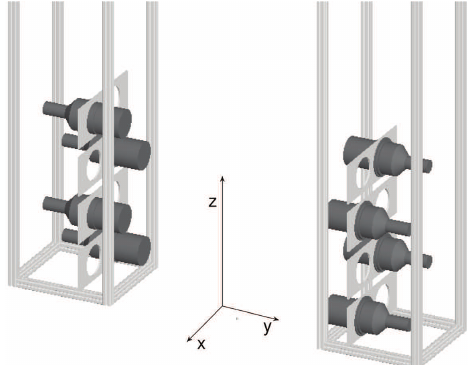
Fig. 4. Schematic drawing of the detector configuration in the test set-up employed at AB SVAFO showing the two detection assemblies and the mechanical support structure. The horizon- tal distance between the front faces of the detection assemblies is 1.0 m. Taken from reference